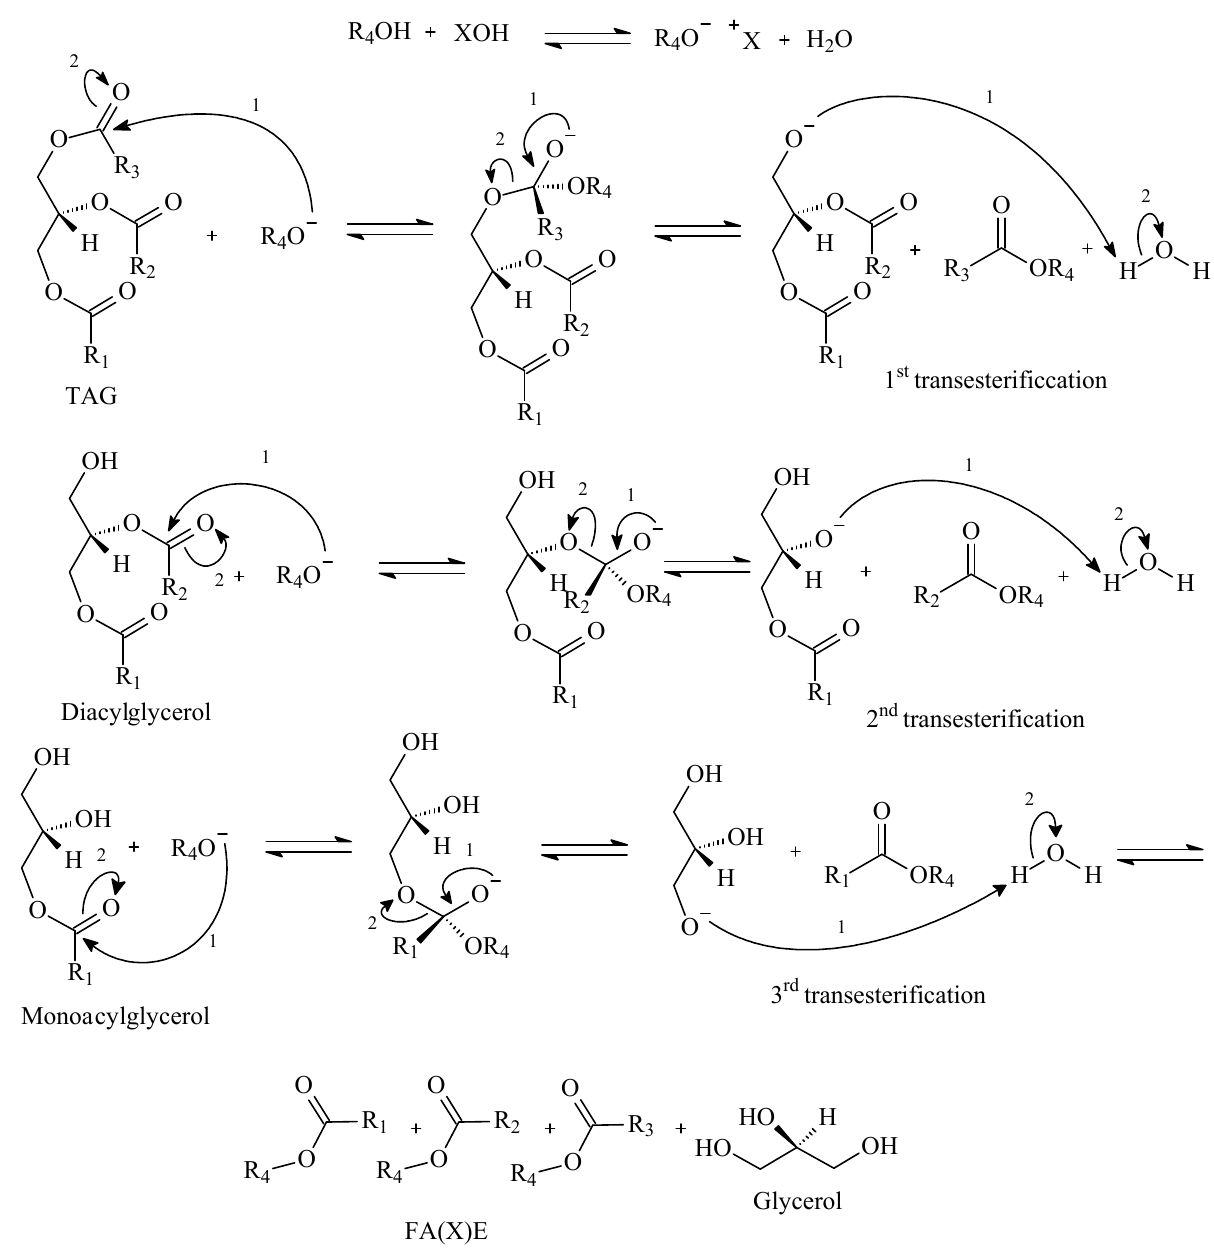
Figure 5. Generic basic reaction mechanism for conversion of TAG to FA(X)E.